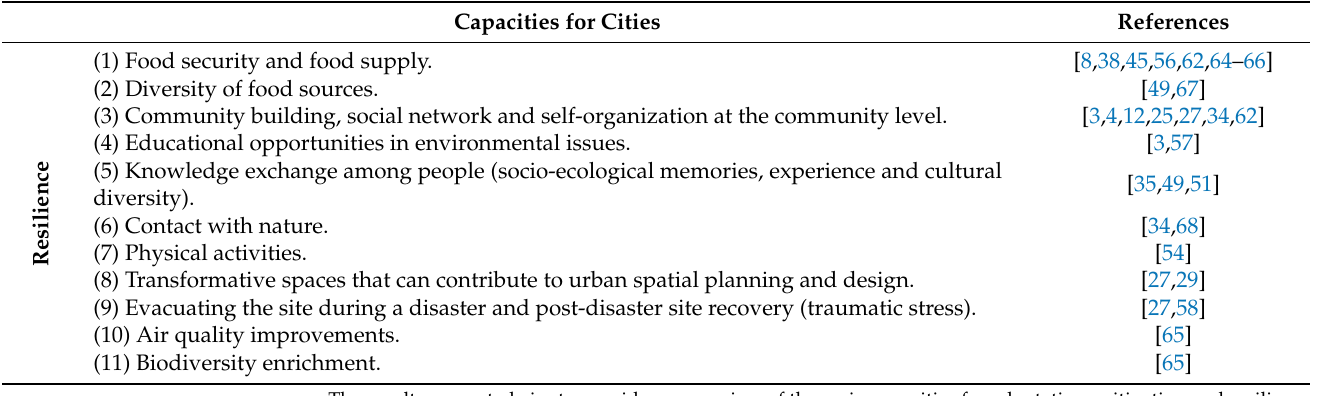
Table 4. Cont. Capacities for